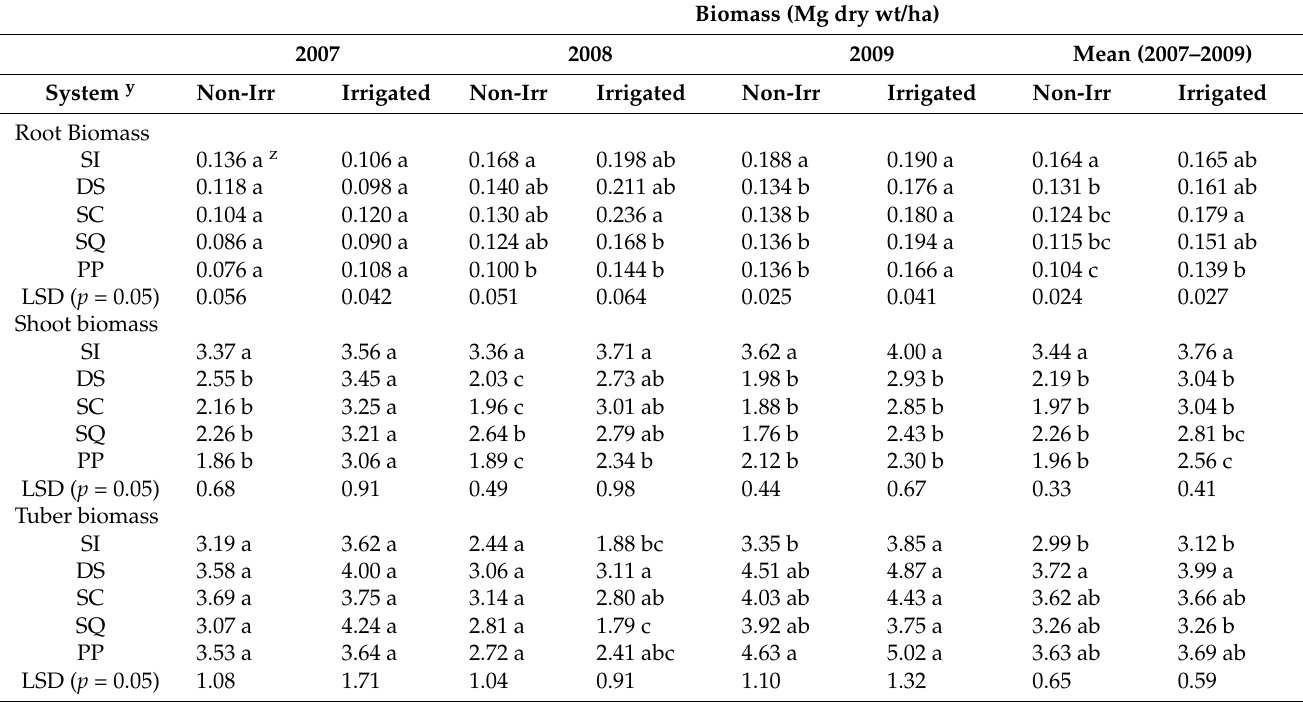
Table 6. Effect of different cropping systems on potato plant root and shoot biomass (dry wt) over three field seasons (2007–2009) under irrigated and non-irrigated